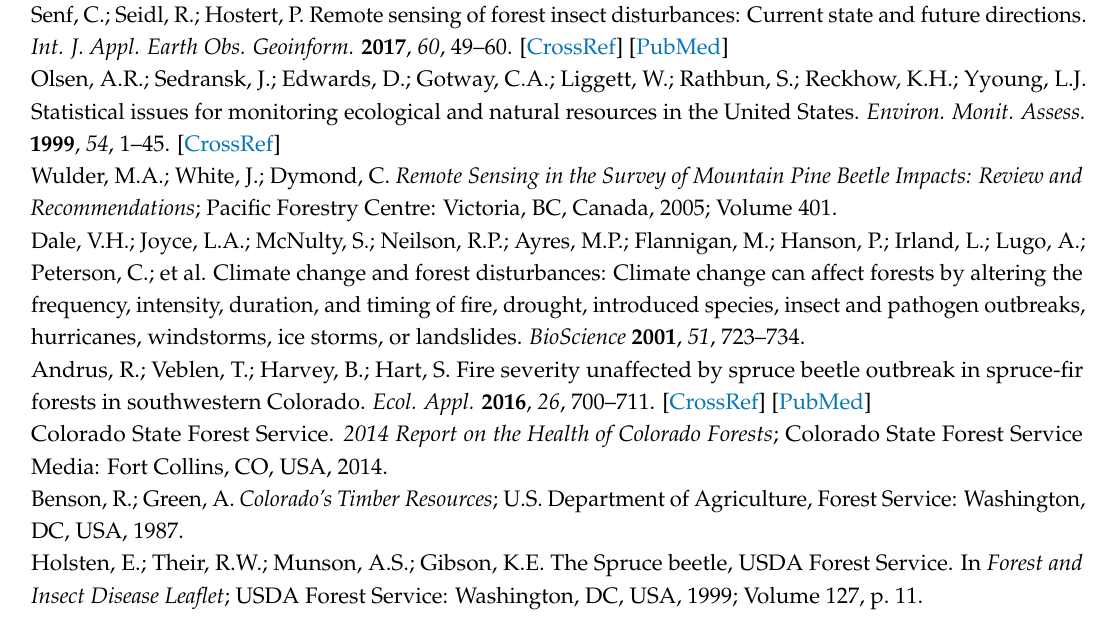
Figure S1: Plots of predicted values versus observed values for the 2011 and 2015 final